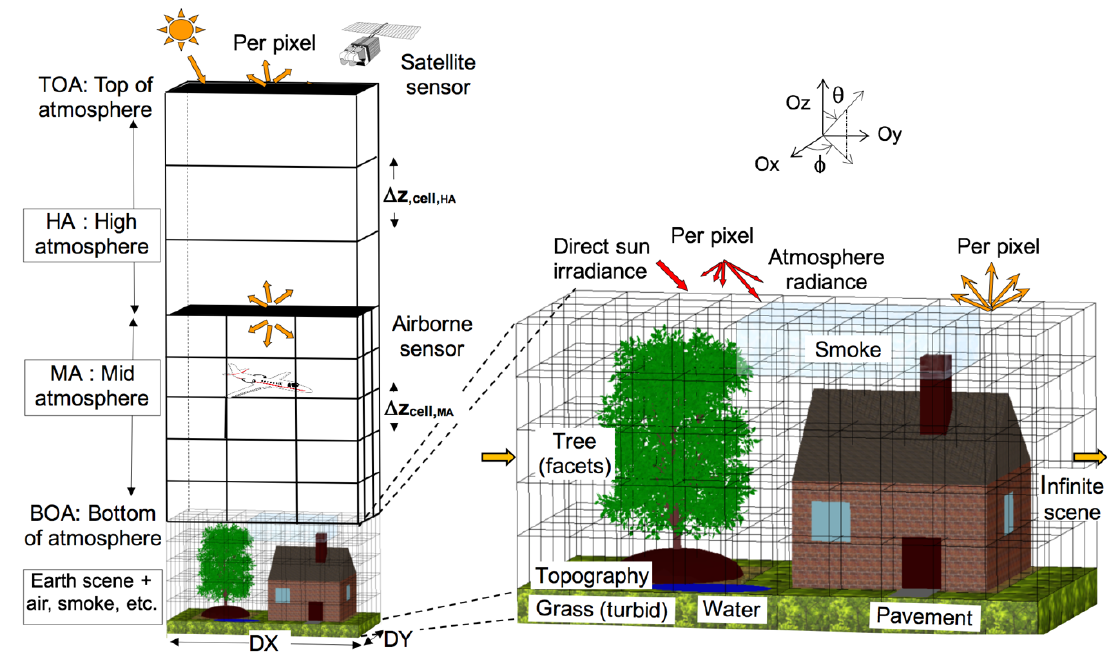
Figure 1. DART 3D discrete mock-up. Landscape elements are made of facets (triangles), and/or fluid and turbid vegetation voxels. The simulated landscape is represented by a cell matrix in order to optimize ray tracing. The atmosphere is represented by three volumes: upper level (HA) made of layers, middle level (MA) made of voxels of any size, and lower level (BA) in the landscape cell